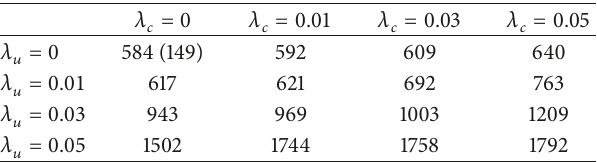
Figure 9: Estimated statistical significance (SS) reach of flavour changing neutral current 𝑡𝑢𝛾 coupling ( 𝜆 𝑢 ) depending on the integrated luminosity ranging from 1fb −1 to 1ab −1 at the LHeC. It includes the contribution from the main background ( 𝐵1 ) on the predicted results. The signal significance corresponding to 2𝜎 , 3𝜎 , and 5𝜎 lines is also shown.